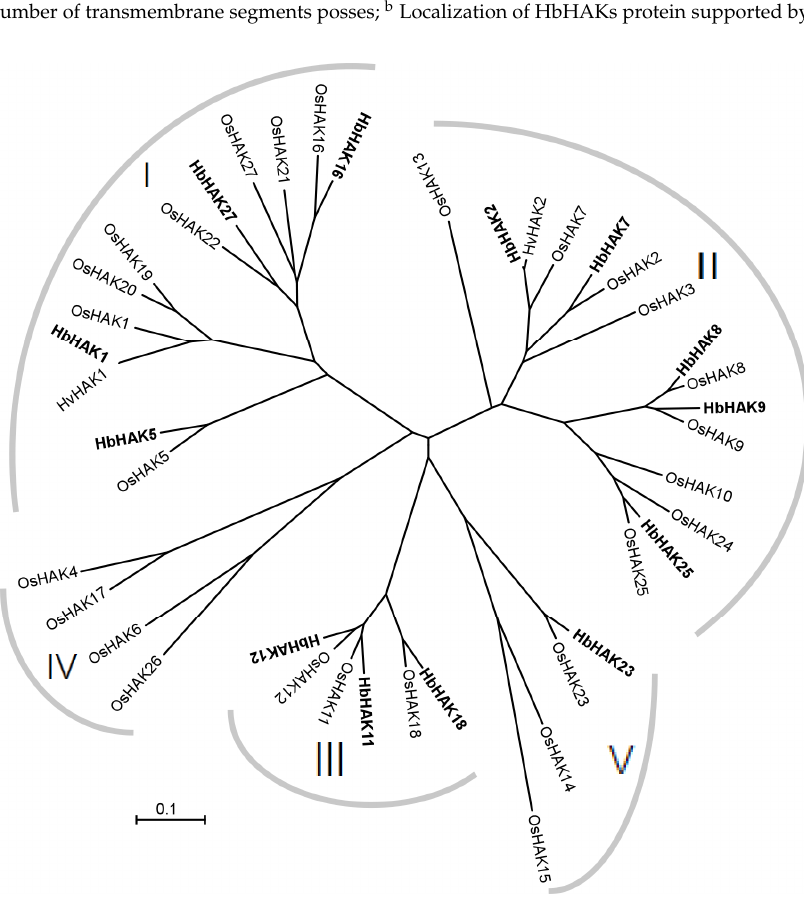
Figure 1. Phylogenetic relationships between identified HAK/KUP/KT proteins in H. brevisubulatum and all the HAK/KUP/KT proteins in rice. Phylogenetic tree was generated with MEG5.0 software (http://www.megasoftware.net/) using the neighbor-joining method. The scale indicates the genetic distance.